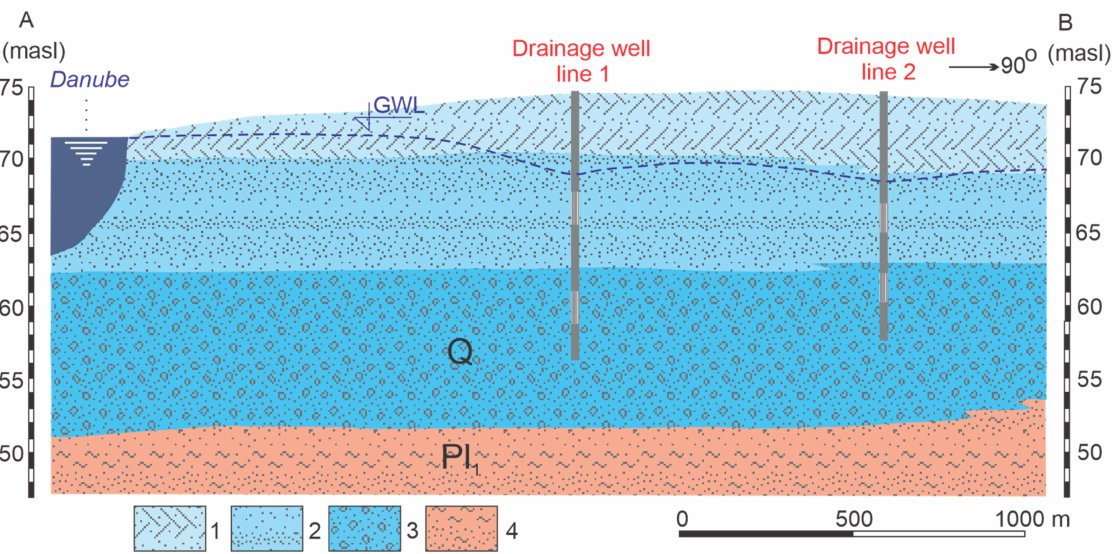
Figure 2. Hydrogeological cross-section A–B (Figure 1). Legend: 1. Sandy clay; 2. Sand; 3.